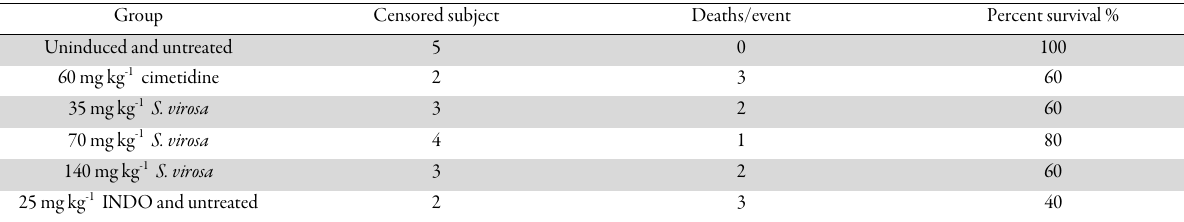
Table 2. Experimental survivor of rats in each